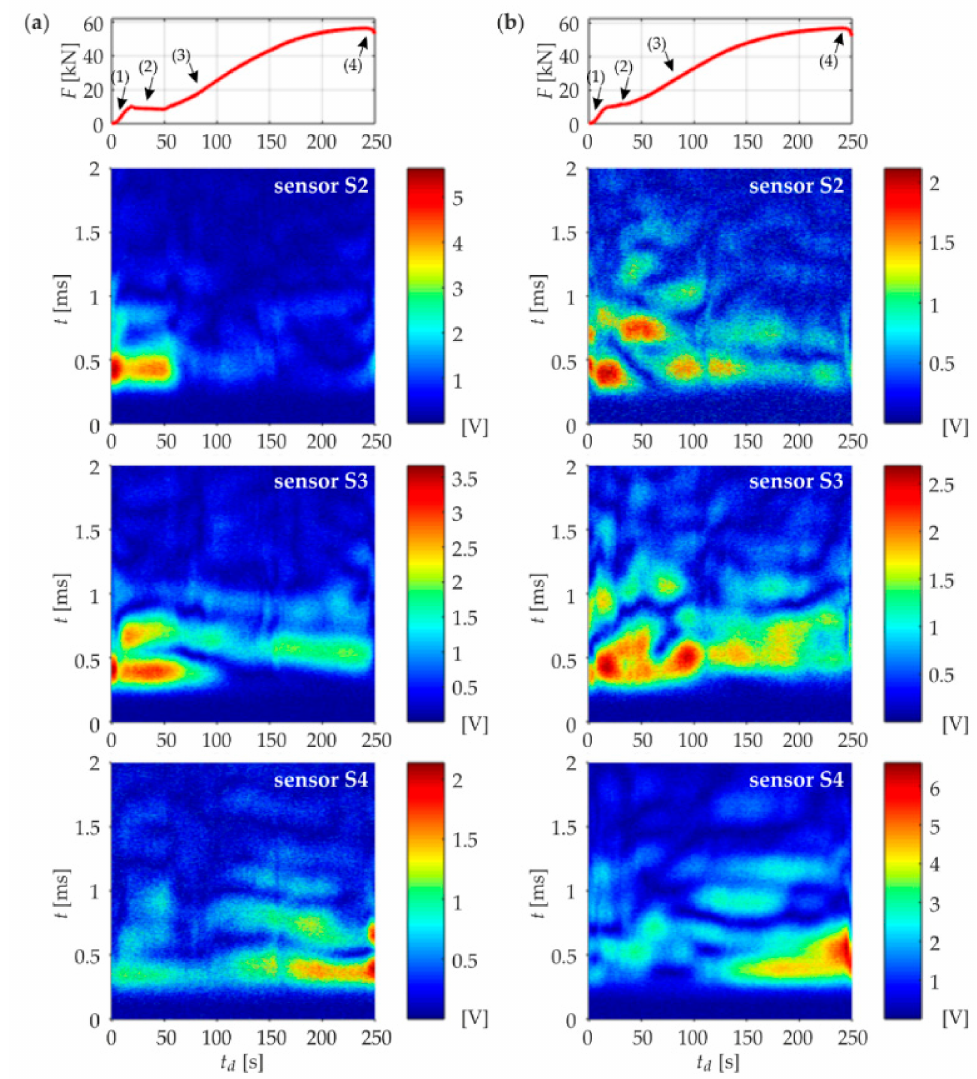
Figure 7. Envelopes of wave propagation signals registered during the tensile tests: ( a ) specimen #1; and ( b ) specimen